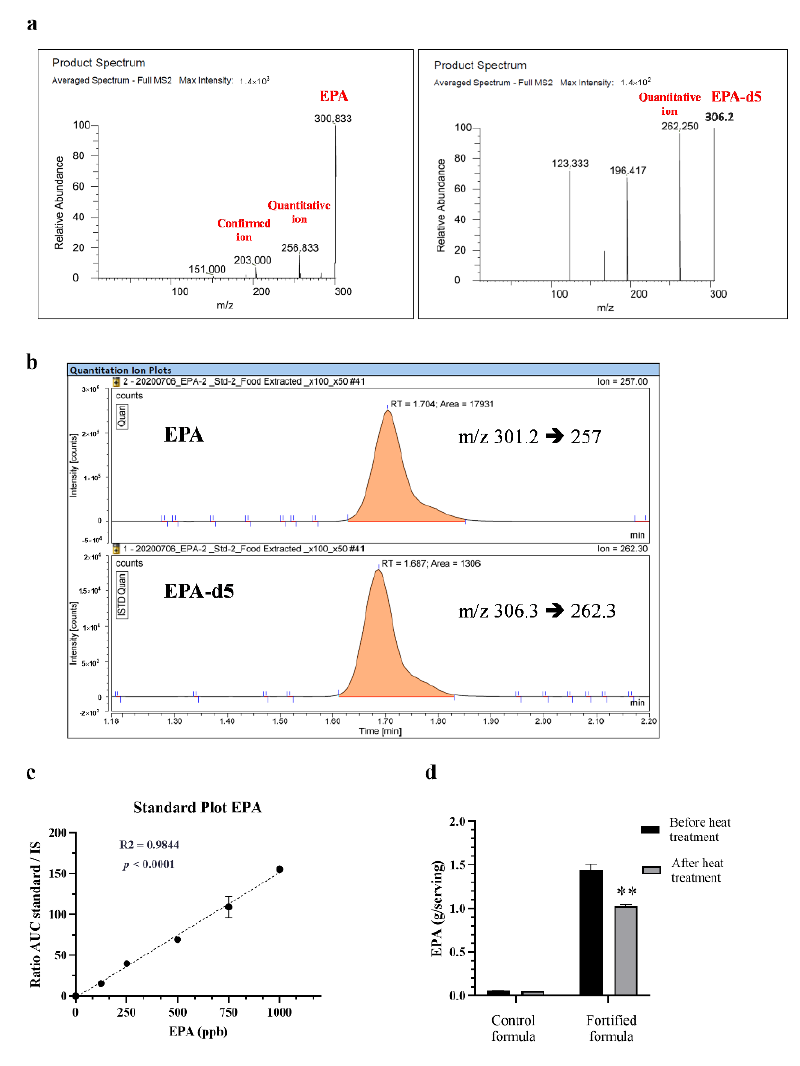
Figure 4. Effect of retort sterilization on the amount of EPA in control and fortified formulas. Precursor ion spectrum and product spectrum of EPA ( a )-left panel) and the internal standard, EPA-d5 ( a )-right panel). The number under EPA or EPA-d5 represents the mass per charge ( m / z ) ratio of the precursor (b). Standard curves of EPA ( c ), obtained from the ratio of area under the curve (AUC) between respective standards and internal standards and the concentrations of each amino acid, analyzed by LC-MS/ MS. R2 and p -values were obtained by using linear regressions. Bar graphs show the amount of EPA ( d ) in the control and fortified formulas before and after retort processing. ** means p < 0.01, comparing before and after retort by using paired